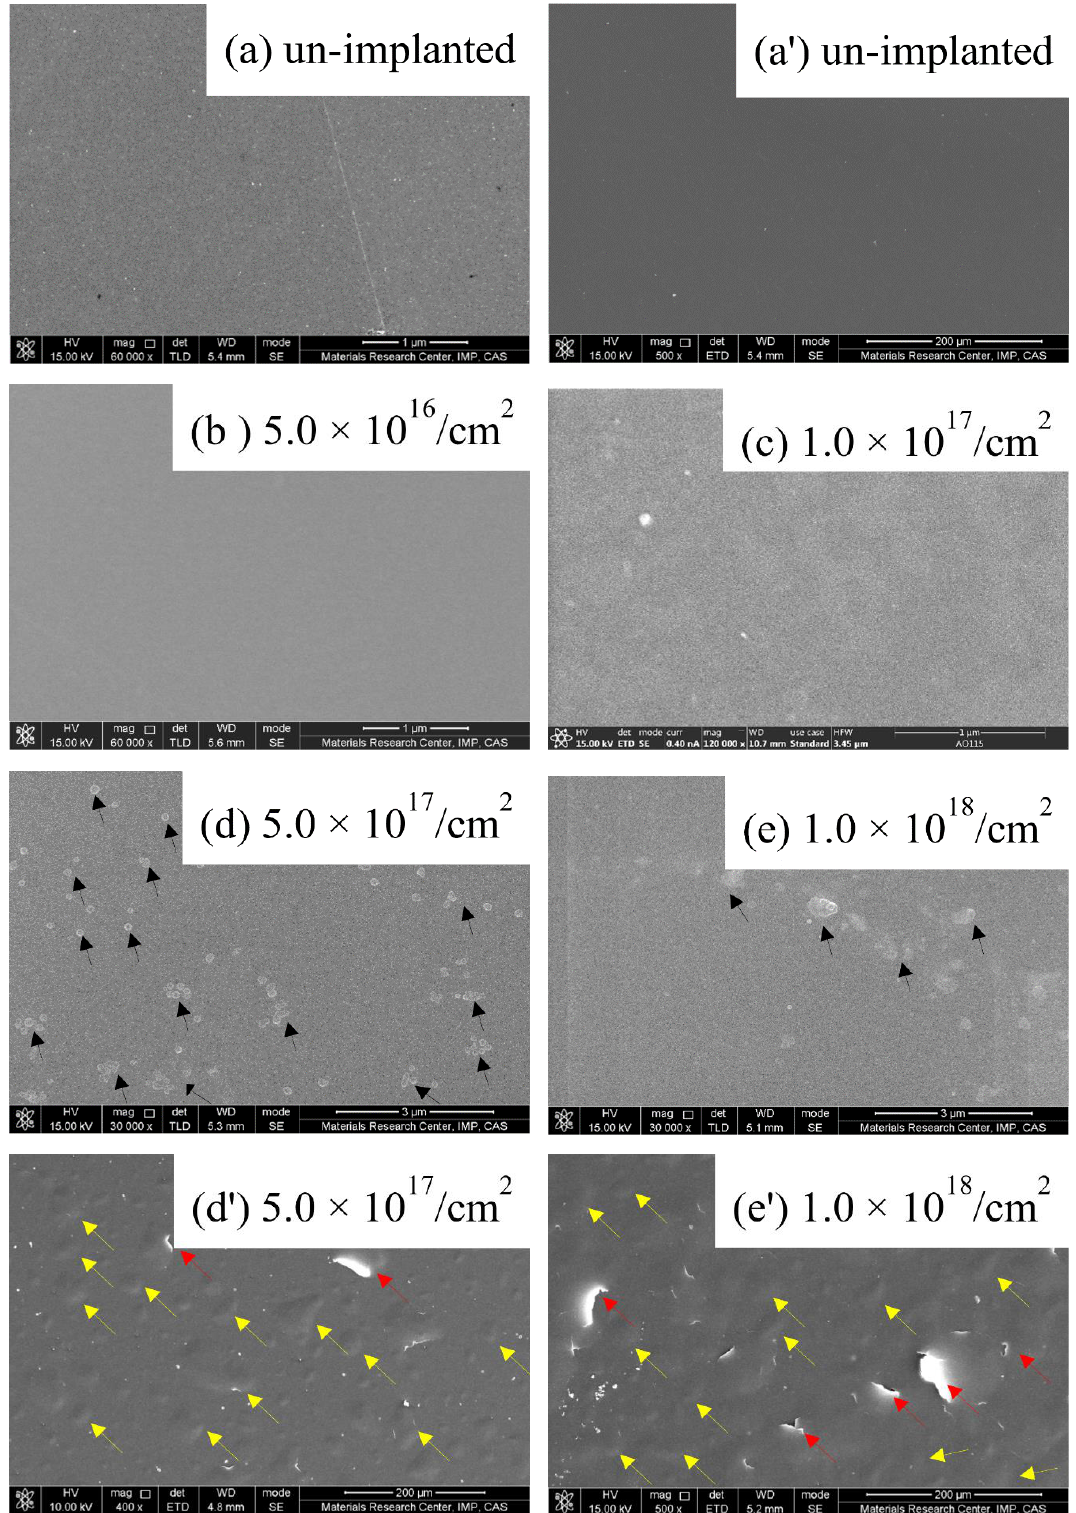
Figure 2. SEM micrographs of un-implanted sample ( a ) and ( a’ ) and helium ion implanted samples to ( b ) 5.0 × 10 16 ions/cm 2 , ( c ) 1.0 × 10 17 ions/cm 2 , ( d , d’ ) 5.0 × 10 17 ions/cm 2 , and ( e , e’ ) 1.0 × 10 18 ions/cm 2 . ( a – d ) and ( e ) show the pictures at a larger magnification. ( a’ , d’ , e’ ) show the mor- phologies at a lower magnification. Some blisters and their burst are pointed by arrows.